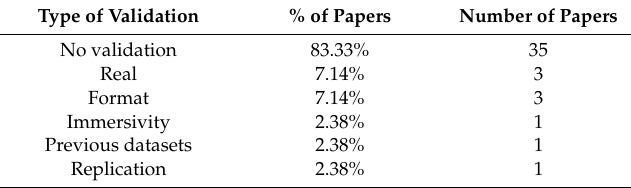
Table 3. Previous research that included analyses of the validation of virtual reality